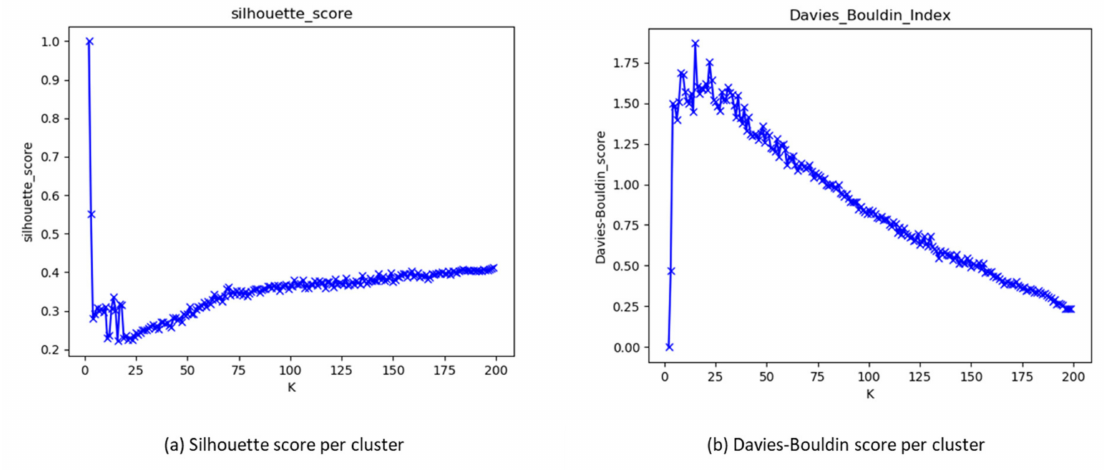
Figure 2. Clustering quality scores: ( a ) using the Silhouette score and ( b ) using the Davies-Boulding score.